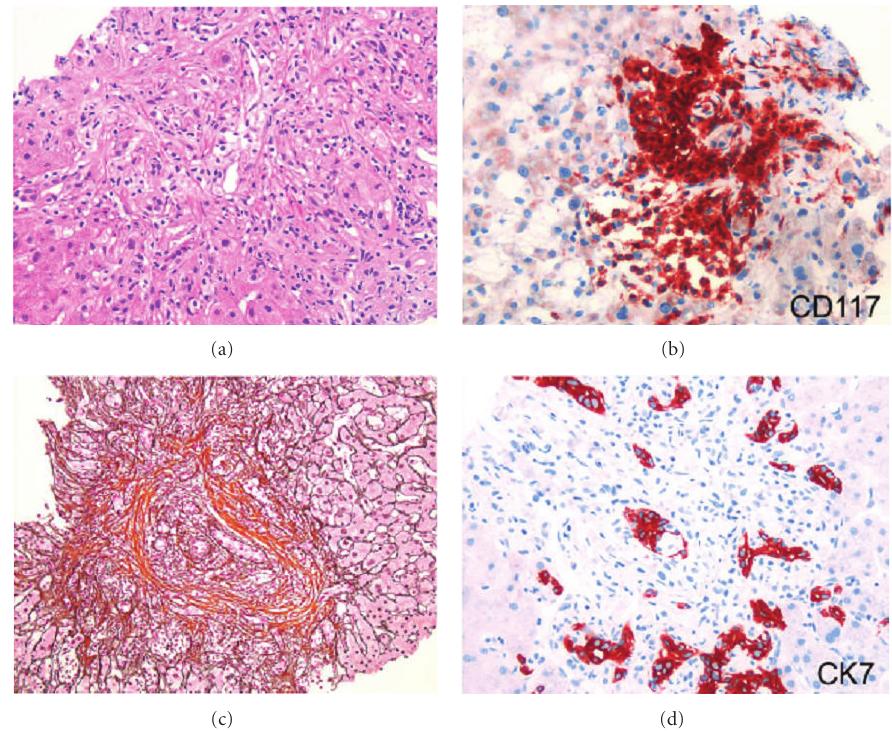
Figure 1: Liver biopsy of the patient with drastically increased liver sti ff ness due to mast cell infiltrates. (a) Infiltration of portal tract and liver sinusoids with neoplastic mast cell like cells (HE). (b) CD117 immunostaining shows nodular infiltration with mast cells. (c) Portal, periportal, and perisinusoidal fibrosis (modified Gomori stain. 200 × ). (d) CK7 immunostain identifies neoplastic mast cells that infiltrate the portal bile ducts and ductular structures 200 ×